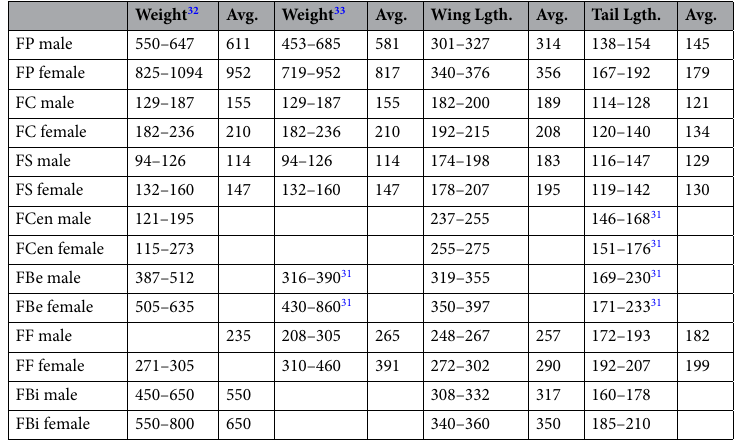
Table 3. Weight (g), wing and tail length (mm) of F. peregrinus (FP), F. columbarius (FC), F. sparverius (FS), F. cenchroides (FCen), F. berigora (FBe), F. femoralis (FF) and F. biarmicus (FBi).